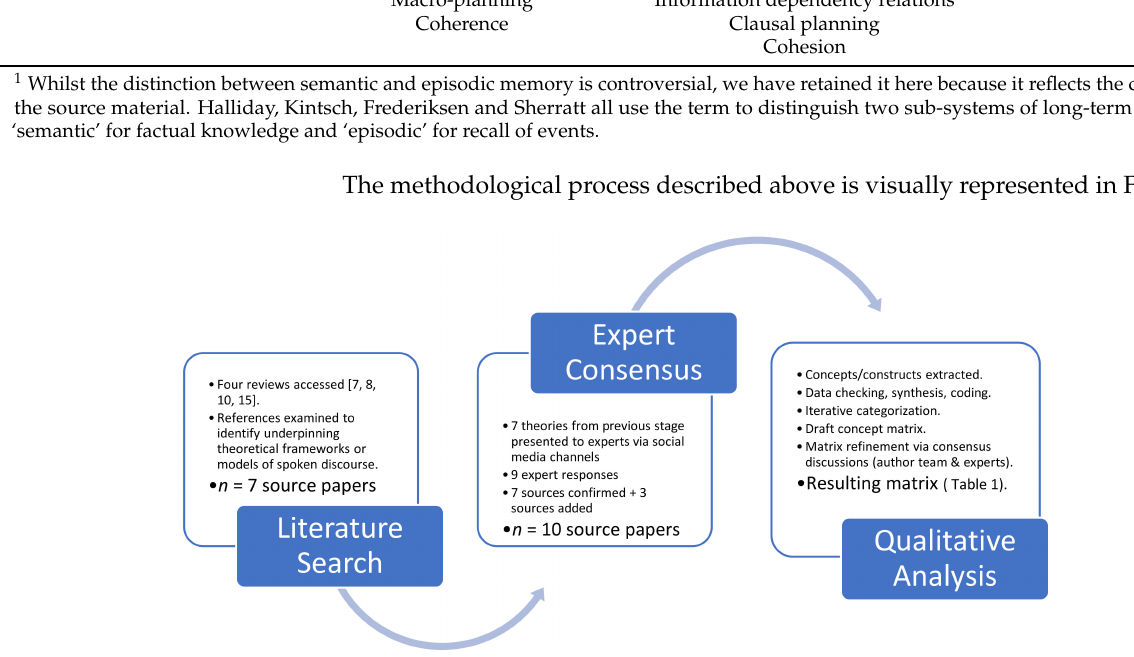
Figure 1. The metatheory process for the Linguistic Underpinnings of Narrative in Aphasia (LUNA)